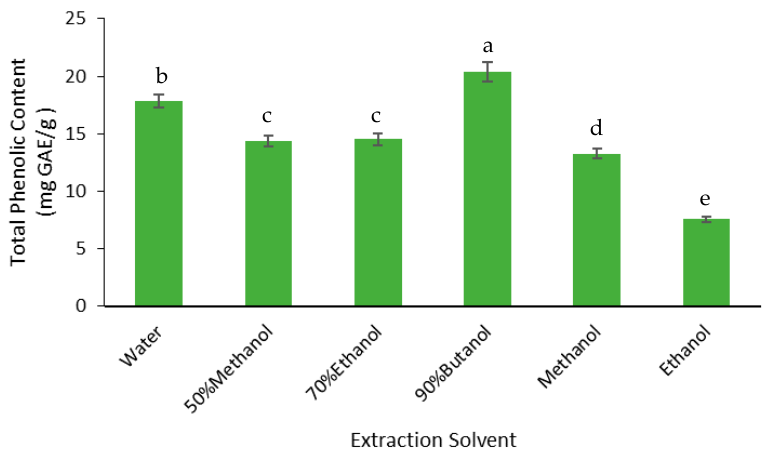
Figure 4. Effect of solvent on the total phenolic content (TPC) of the FD Gac seed crude extracts. The values were the means ± SD of three replicate extractions for each solvent. Columns not sharing the same letter were significantly different at p < 0.05. GAE, Gallic acid equivalents.